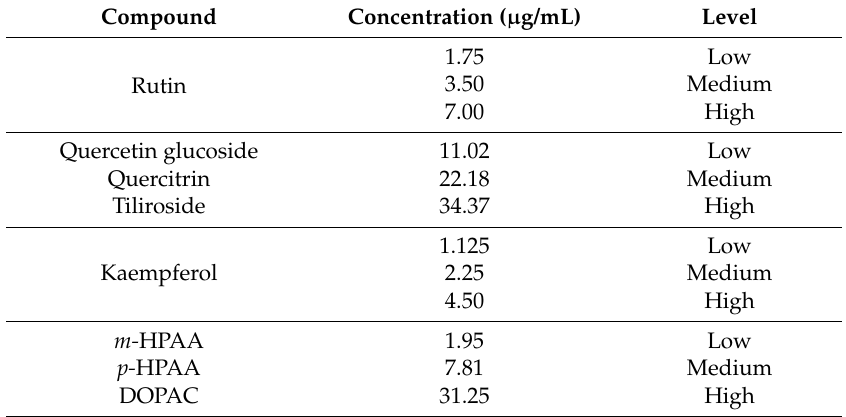
Table 4. Concentrations used in the different tests for the validation of the analytical methods.